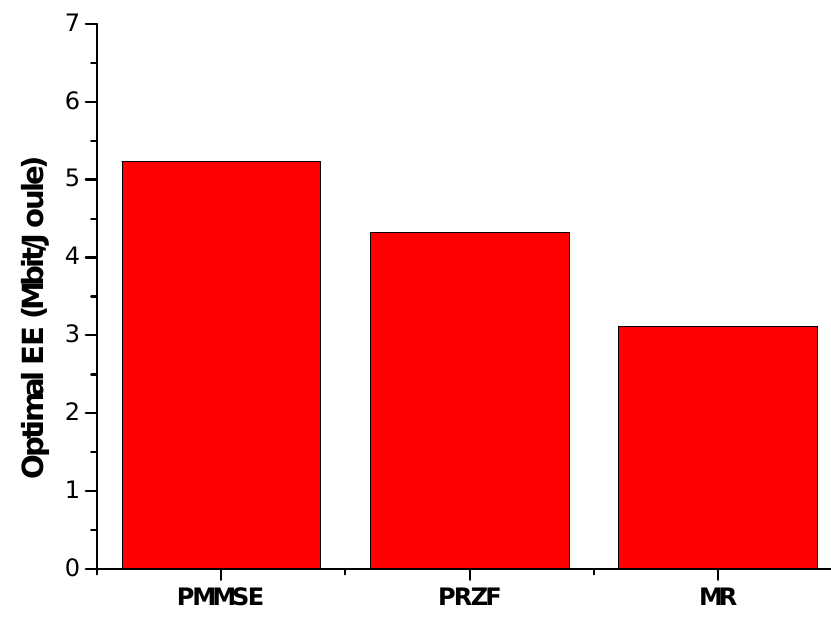
Figure 6. Optimal EE achieved with different combining